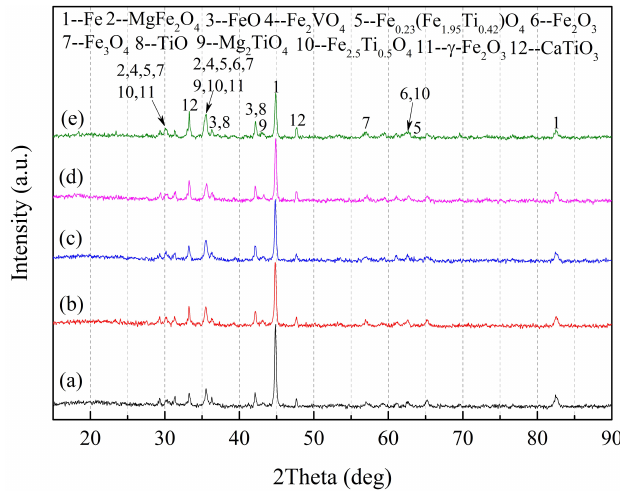
Figure 9. XRD pattern of reductive CVTM sinters with different TiO 2 content. (a) TiO 2 = 5.85%; (b) TiO 2 = 7.35%; (c) TiO 2 = 8.85%; (d) TiO 2 = 10.35%; (e) TiO 2 = 11.85%. (b) TiO 2 = 7.35%; (c) TiO 2 = 8.85%; (d) TiO 2 = 10.35%; (e) TiO 2 =